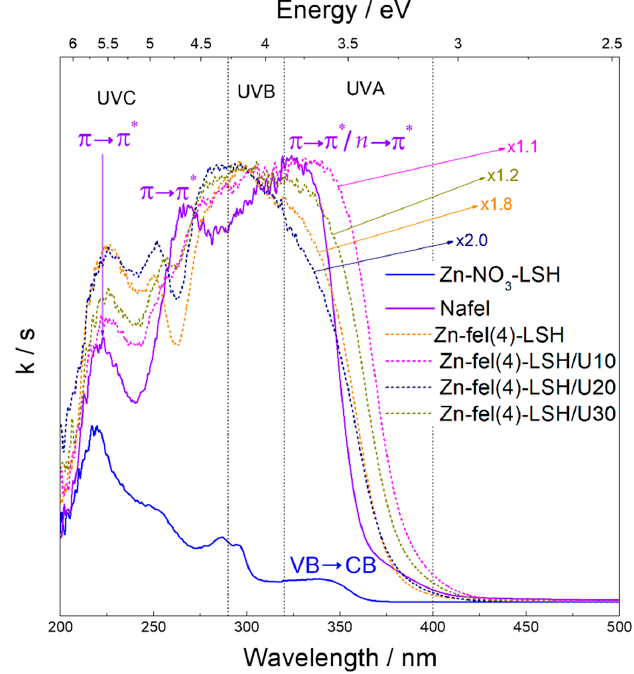
Figure 9. Absorption spectra of Zn-NO 3 -LSH, Zn-fel(4)-LSH, Zn-fel(4)-LSH/U10, Zn-fel(4)-LSH/U20, Zn-fel(4)-LSH/U30, and Nafel salt (NaC 10 H 9 O 4 ).